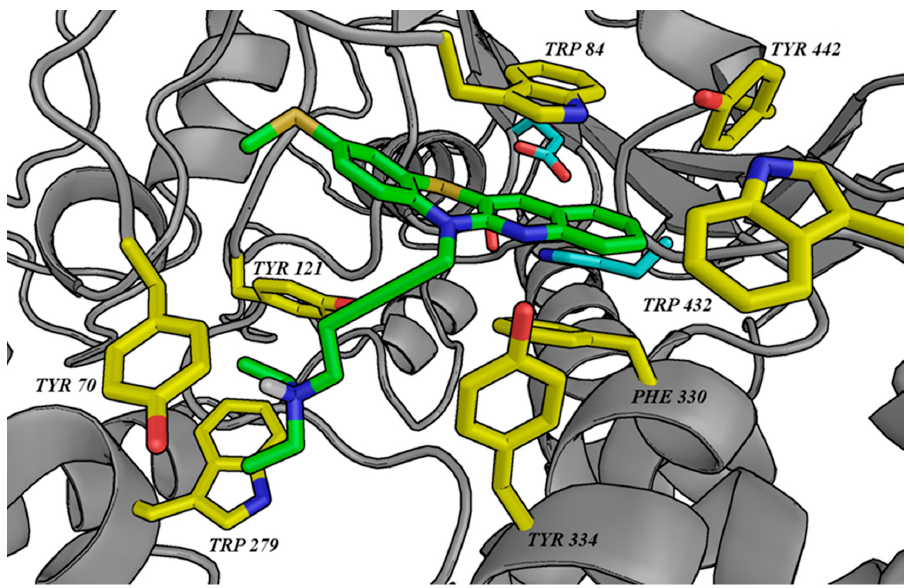
Figure 6. Binding mode of compound 24 in the active site of acetylcholinesterase.